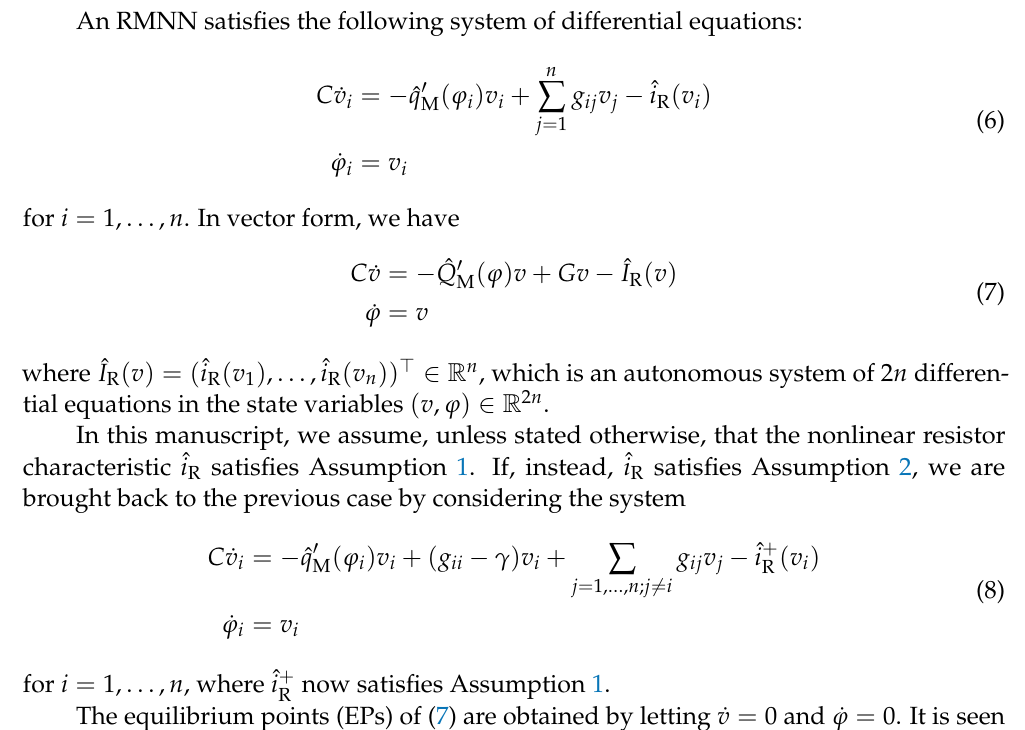
Figure 4. Circuit schematic for the i -th cell of an RMNN. The cell is obtained by replacing the ideal flux- controlled memristor in the cell of an IMNN (cf. Figure 3) with a real extended memristor given by the parallel connection of an ideal flux-controlled memristor and a nonlinear voltage-controlled